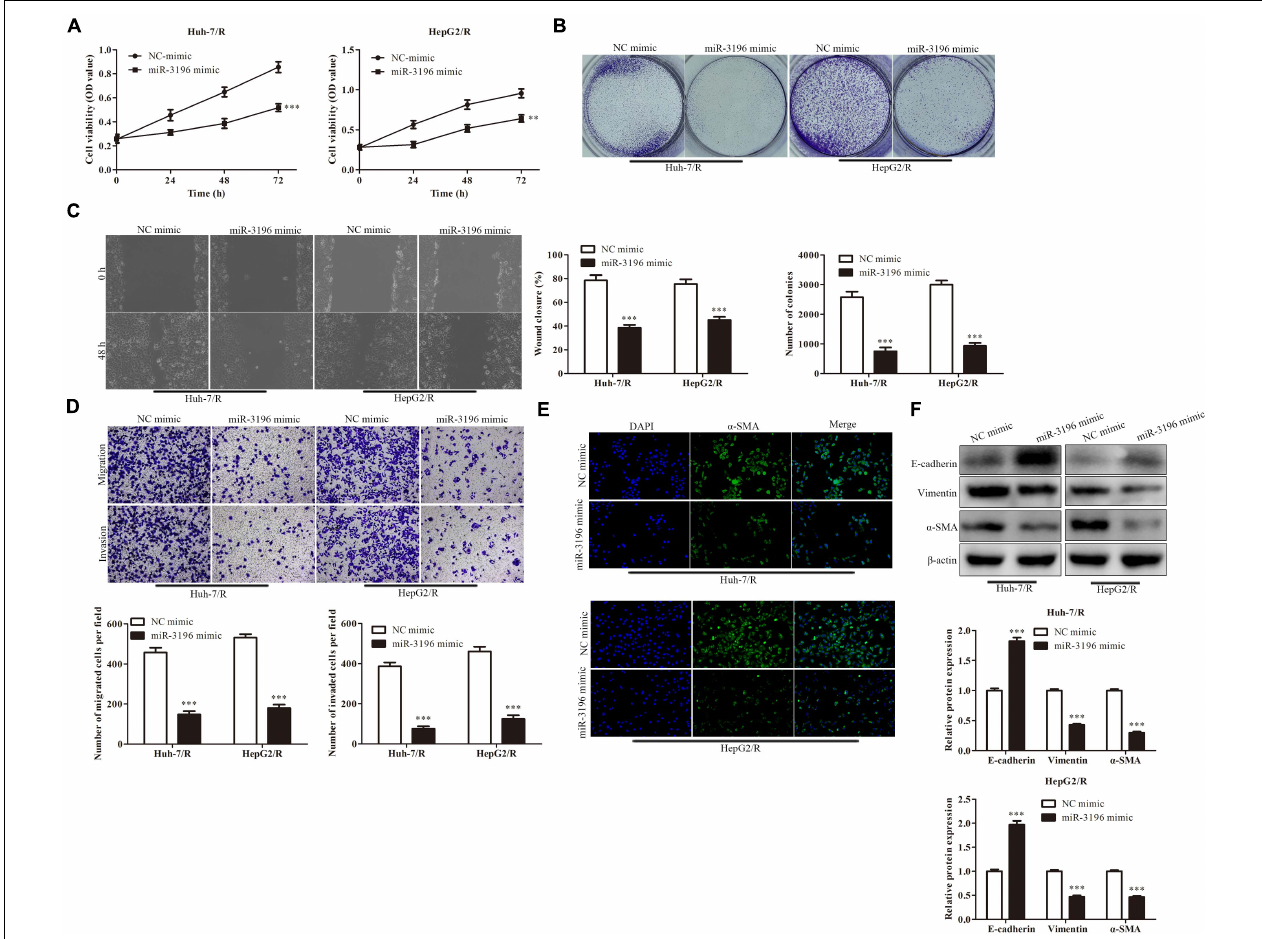
FIGURE 4 | miR-3196 overexpression inhibits proliferation, invasion, migration, and EMT of HCC cells. (A) CCK-8 assay indicated the cell viability in Huh7/R and HepG2/R cells transfected with miR-3196 mimic compared to a negative control. (B) The colony formation abilities of the Huh7/R and HepG2/R cells in miR-3196 mimic compared to the negative control. (C,D) Wound healing assay (C) and transwell analysis (D) to test the effect on the invasion and migration of HCC cells. (E,F) Immunostaining (E) and western blotting (F) detected the EMT of Huh7/R and HepG2/R cells transfected with miR-3196 mimic compared to a negative control. Scale bars: 50 µ m. ** P < 0.01, *** P < 0.001 vs NC-mimic